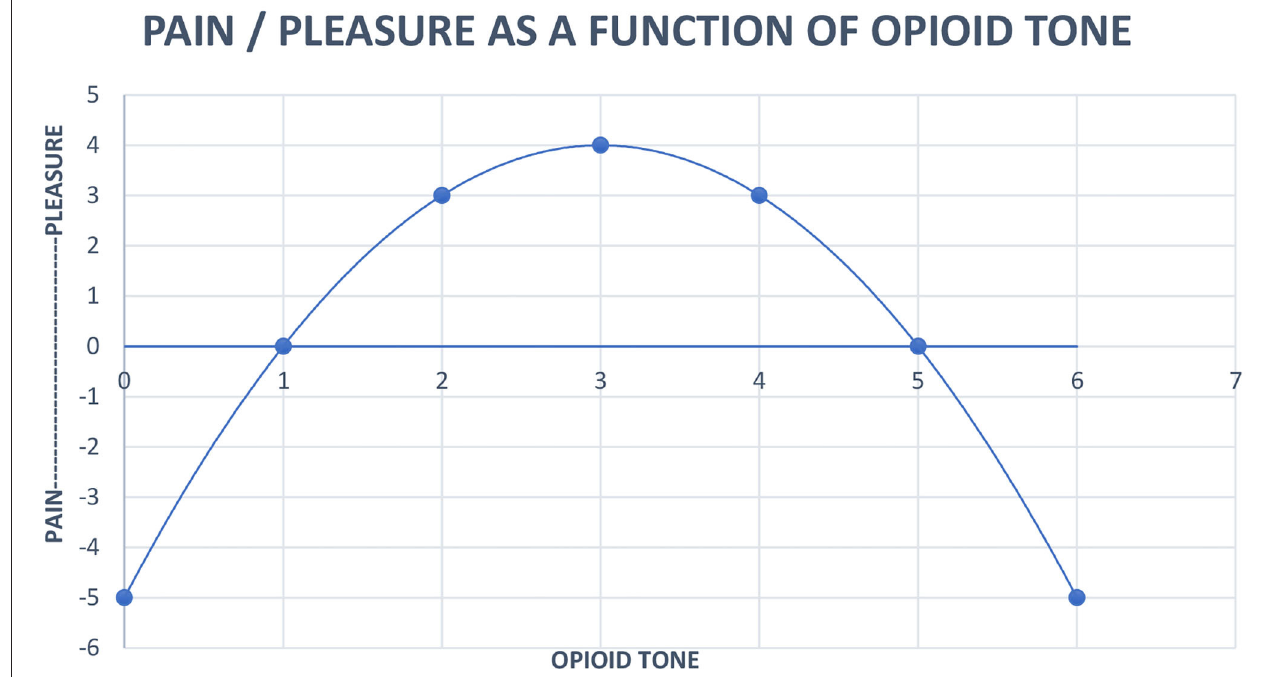
FIGURE 1 | Neurobiological systems engineering model of the relationship of pain, pleasure and opioid